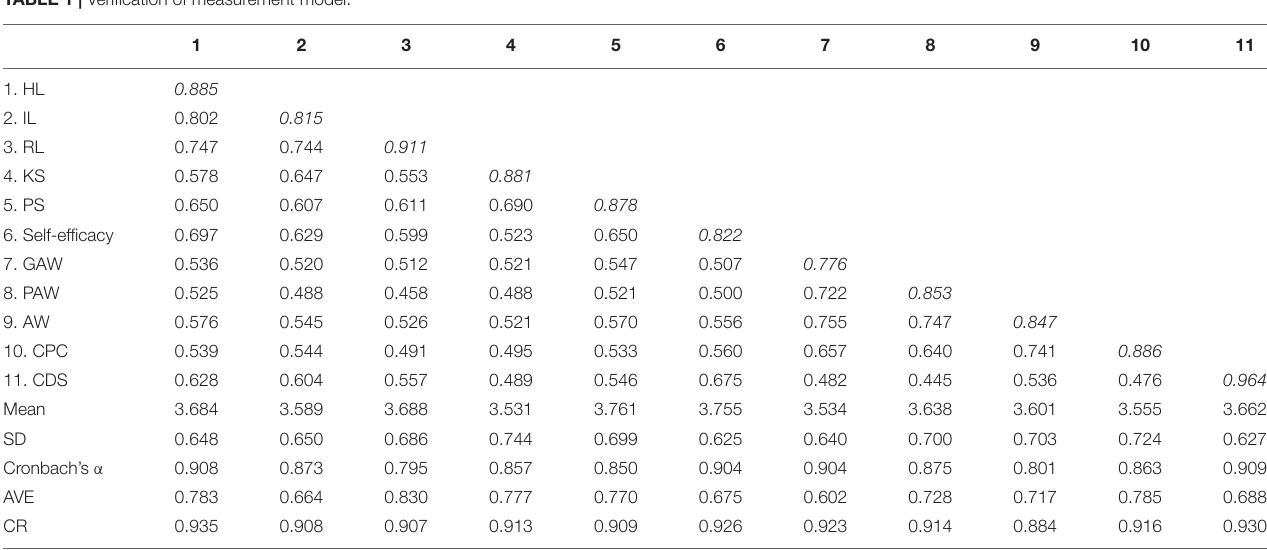
TABLE 1 | Verification of measurement